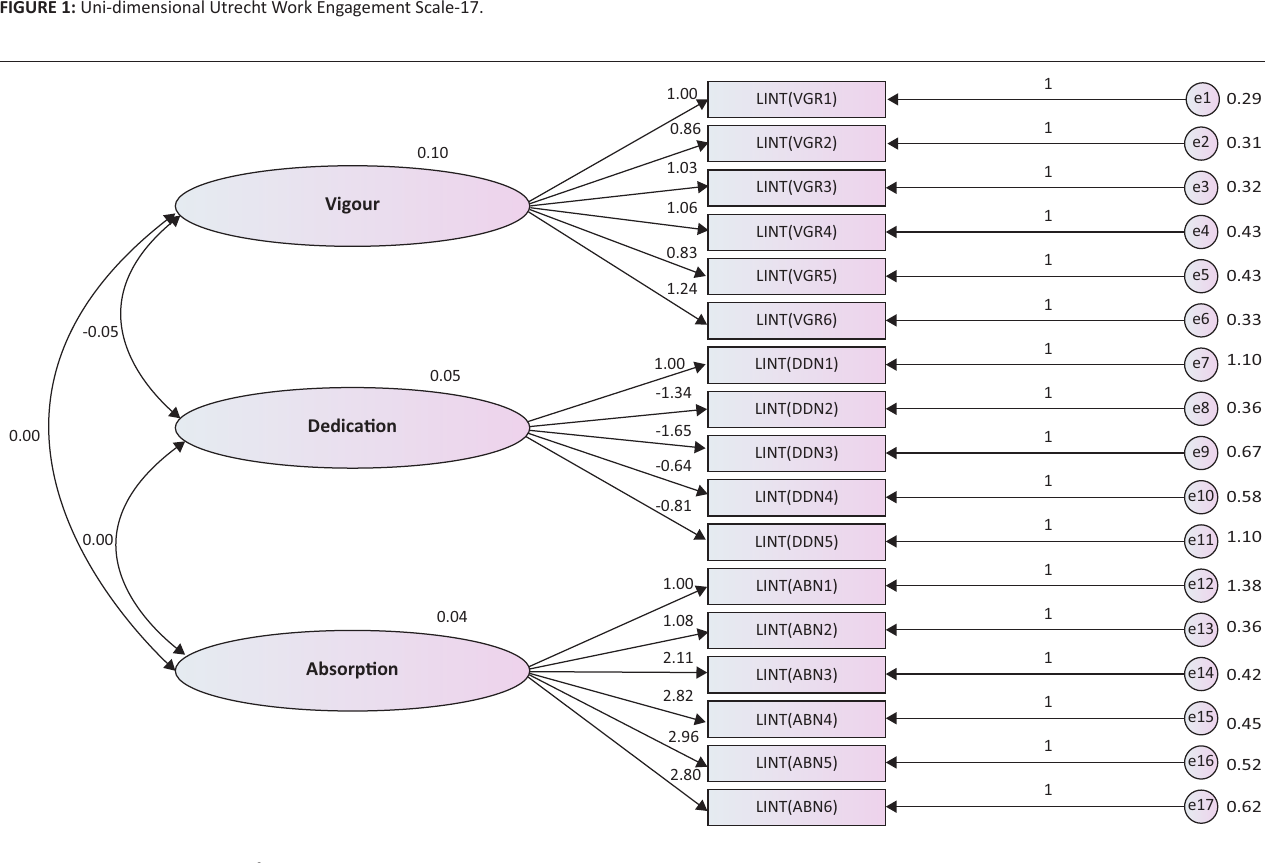
χ 2 = 46.870; df = 41; p = 0.244; RMSEA = 0.025; GFI = 0.965; AGFI = 0.964; CFI = 0.969; TLI = 0.958; NFI = FIGURE 2: Tri-factor Utrecht Work Engagement